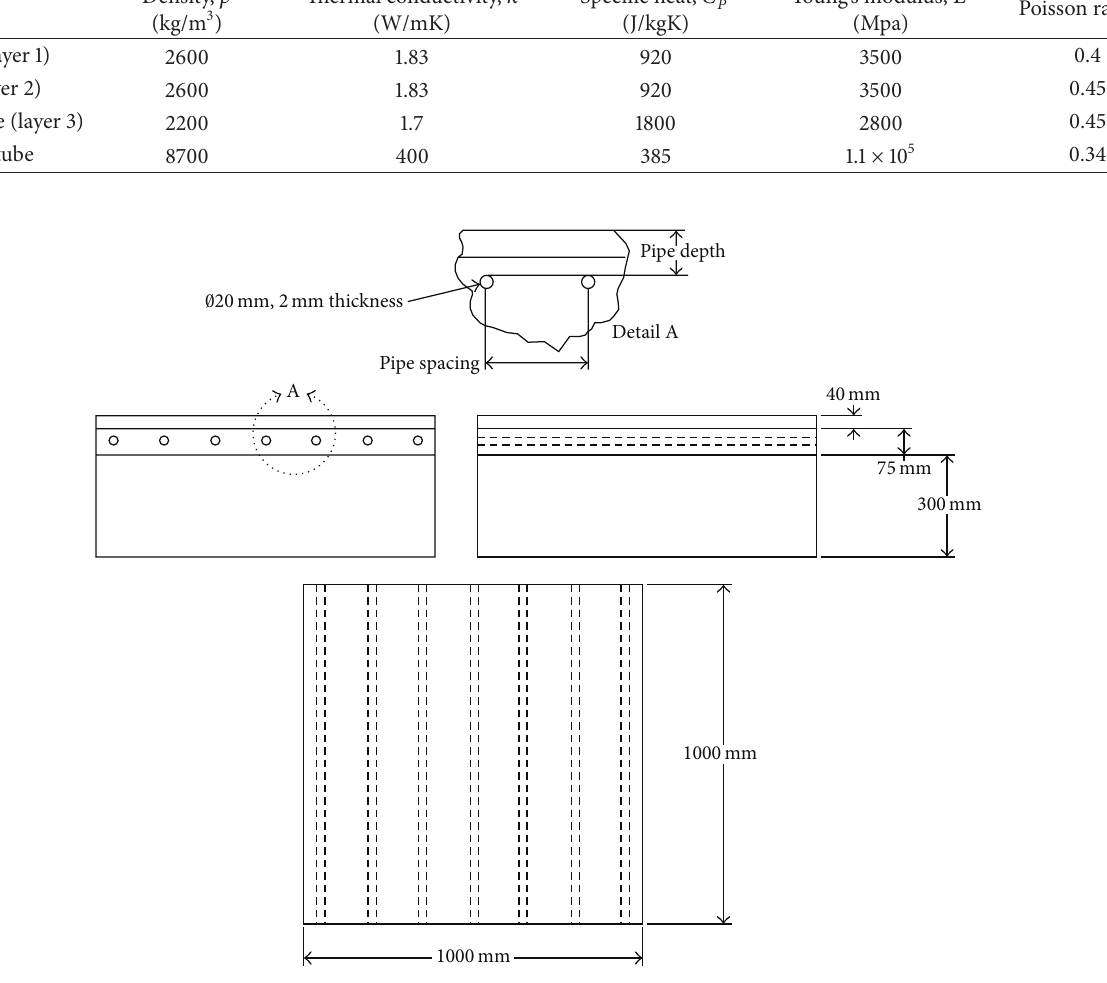
Figure 2: Straight pipe